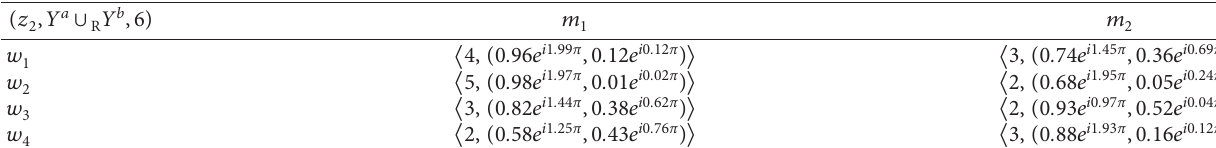
Table 14: Restricted union.